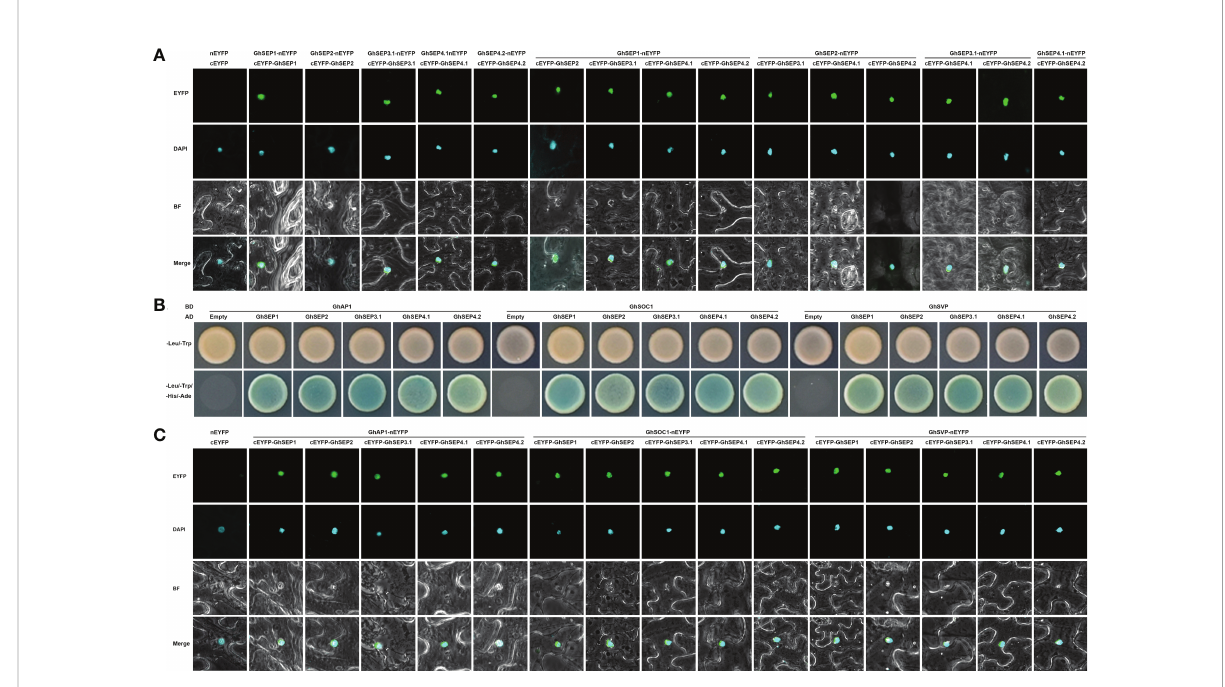
FIGURE 6 Protein interaction between GhSEP proteins and fl owering time regulators. (A) Interaction between GhSEP proteins detected by the bimolecular fl uorescence complementation (BiFC) assay. (B) Interaction of GhSEP proteins and fl owering time regulators detected by the yeast two-hybrid assay. (C) Interaction of GhSEP proteins and fl owering time regulators detected by the BiFC